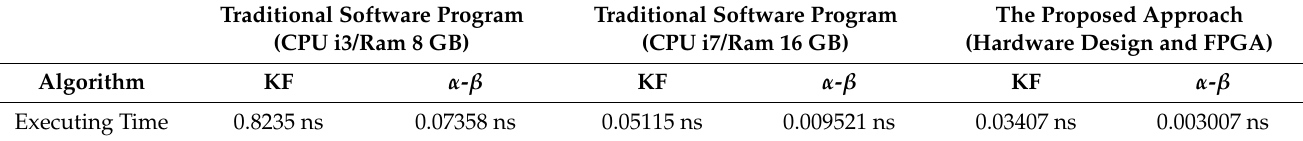
Table 6. Comparison of Hardware Processing Time of Altera (Proposed Tracking